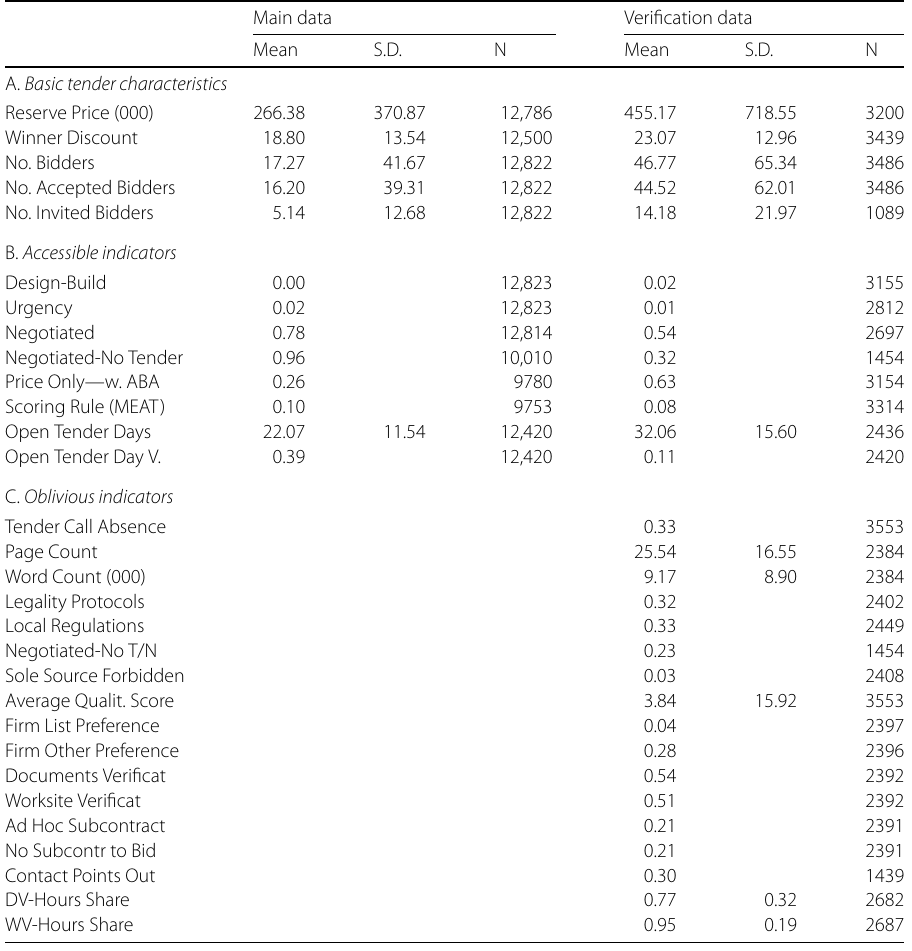
Table 2 Summary statistics for the main and verification